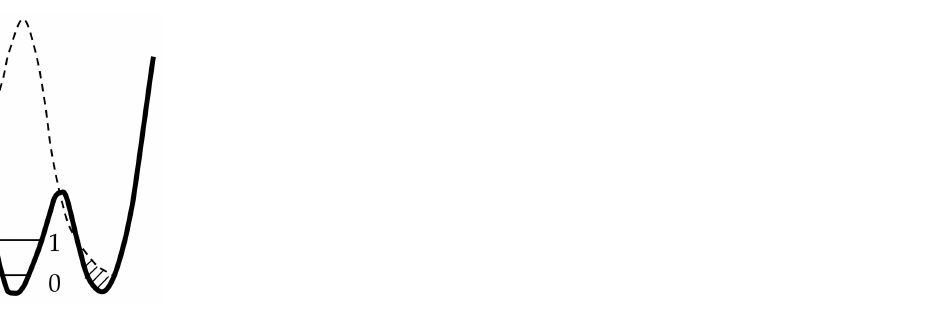
Figure 27. The assumed distribution of the proton density (dashed curve) at d O ··· O < 2.6 Å. The shaded area shows the region where the proton density penetrates into the neighboring well.